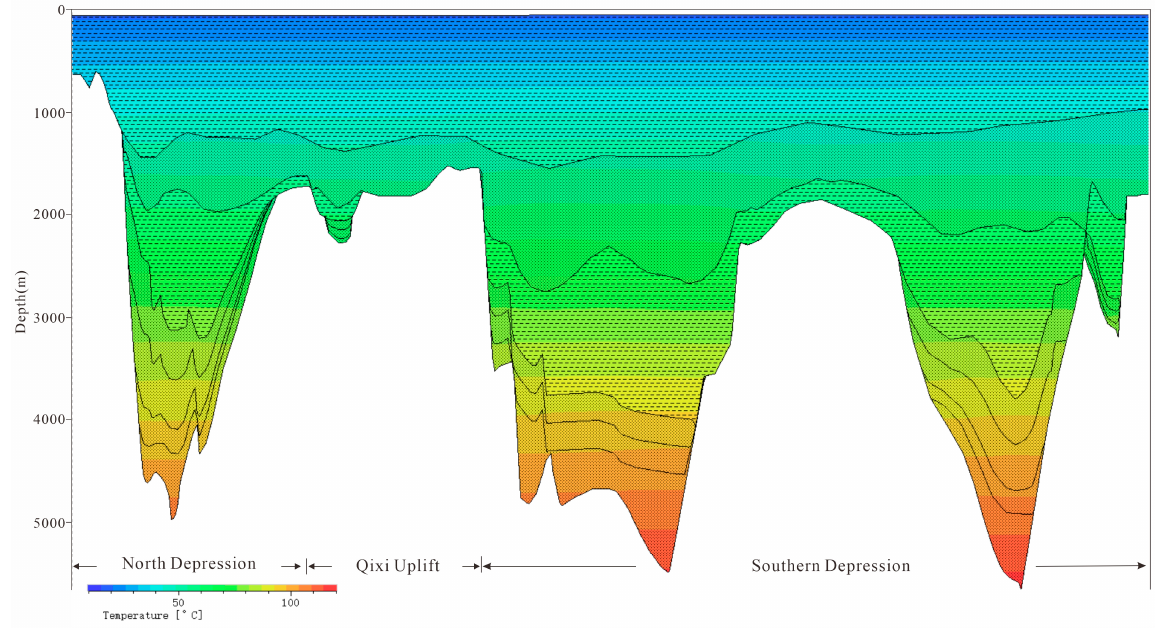
Figure 7. NW-SE stratigraphic temperature profile of the Beibu Gulf Basin (see Figure 1 for profile location).